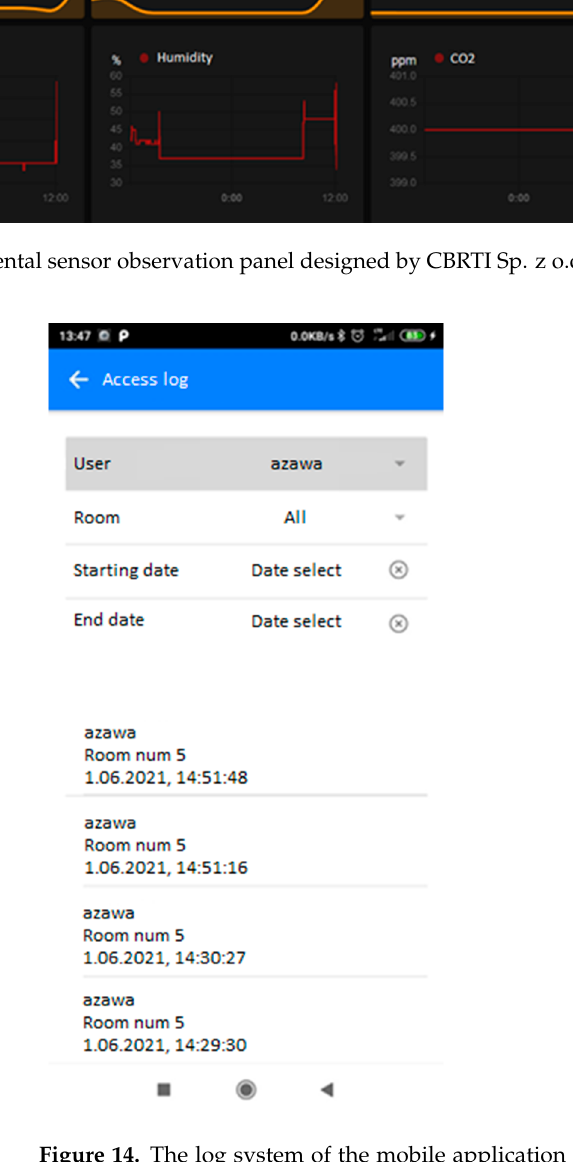
Figure 14. The log system of the mobile application designed by CBRTI Sp. z o.o. Research and Development Center that stores data on the use of rooms.